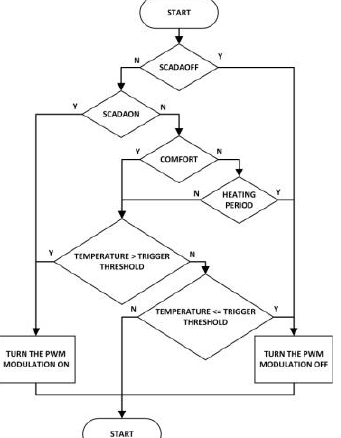
Fig. 2. Control algorithm for the operation of the cooling system in the living room.